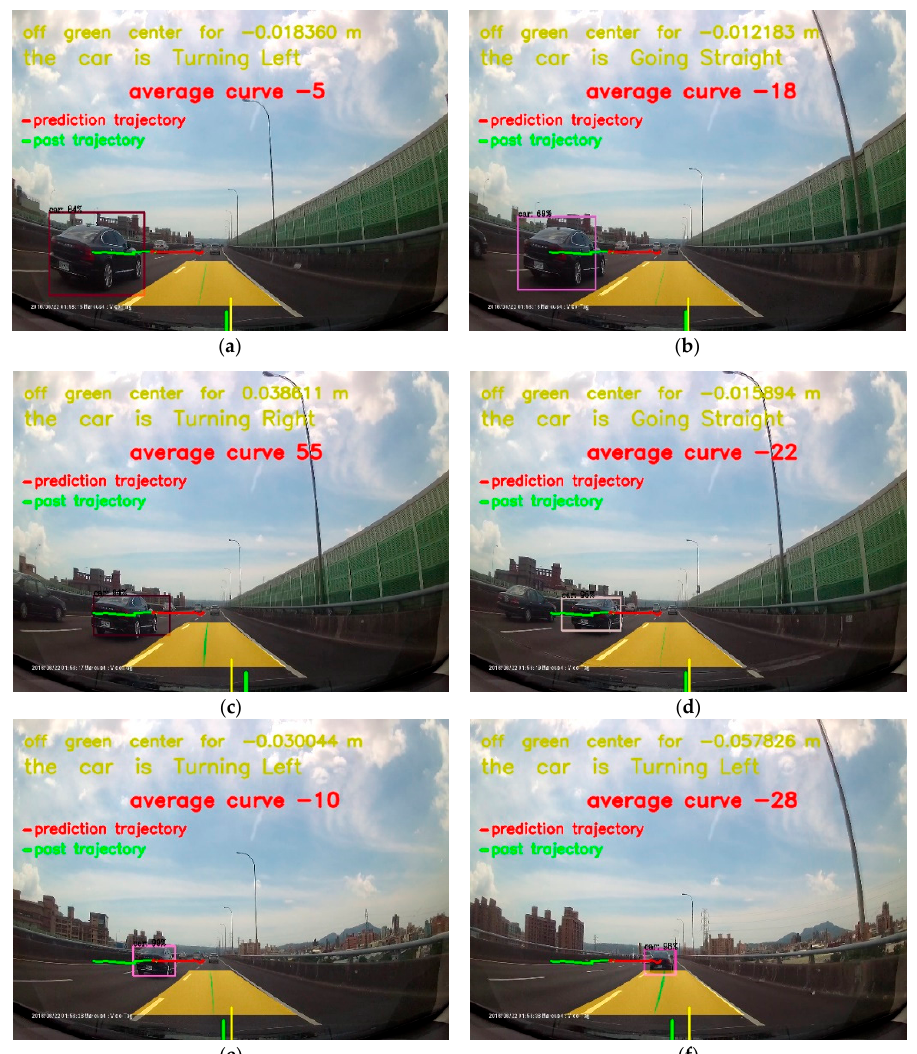
Figure 25. The combination of all techniques of the second validation. We demonstrated the results in three rows: ( a ) the first second the vehicle enters the sight from our left side, ( b – e ) the vehicle moves forward from our left side, ( f ) the last second the vehicle moves forward from our left